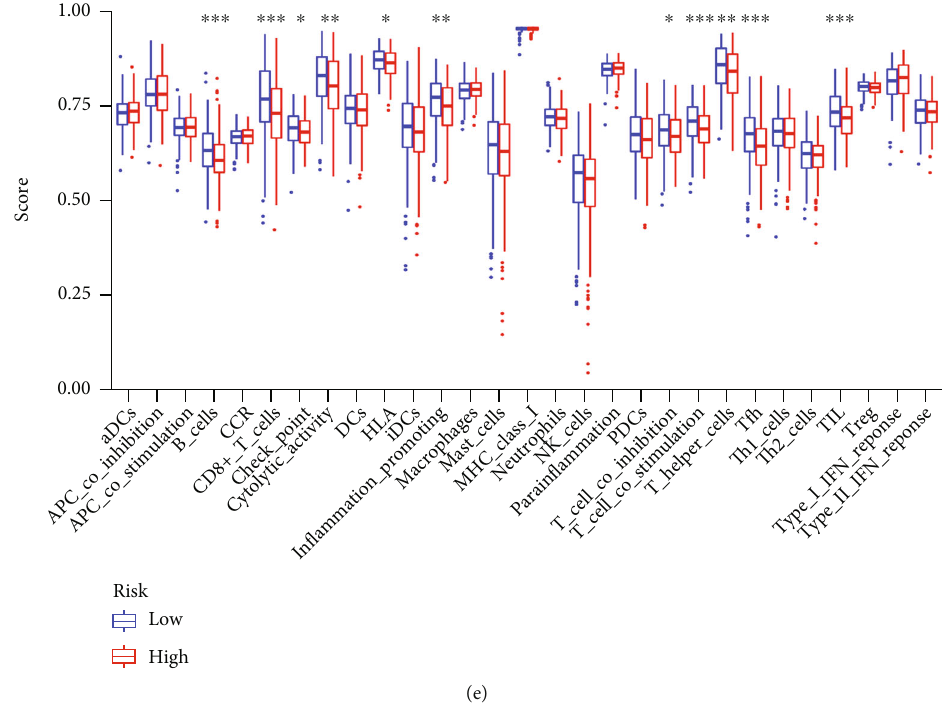
Figure 6: Association between in fi ltrating immune cells and RMA-AS_Score prognostic signature. (a) Relationship between the RMA-AS_ Score signature and immune cells. (b) The assessment of the purity of tumor, the degree, and level of immune cells and stromal cells. (c) Heatmap of immune signatures and immune scores of two di ff erent risk groups. (d) Expression levels of immune cell in two di ff erent risk groups. (e) Enrichment information of immune-related signatures in two di ff erent risk